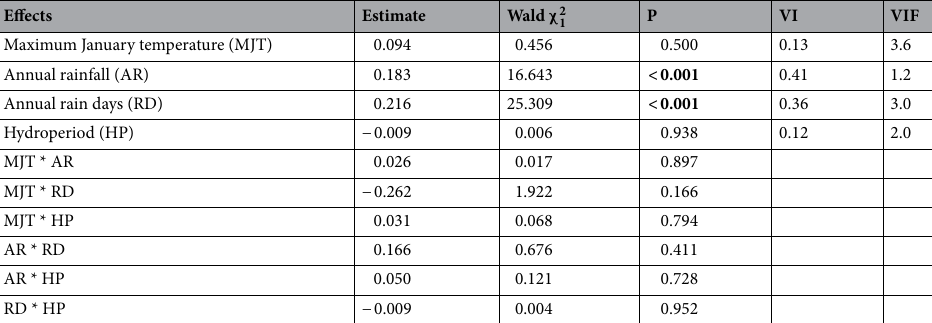
Table 3. The effects of maximum January temperature (C), annual rainfall (mm), number of rainy days (> 0.1 mm/day), and length of hydroperiod (days) on the frequency of alleles. The four climatic variables were standardized within each pool. Significant effects are indicated in bold. Variable importance is denoted by VI and the variance inflation factor by